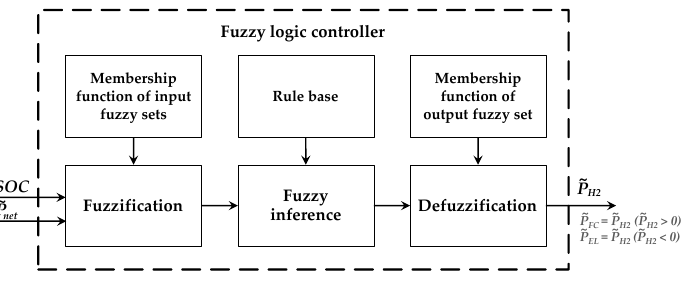
Figure 2. Block diagram of a fuzzy logic controller